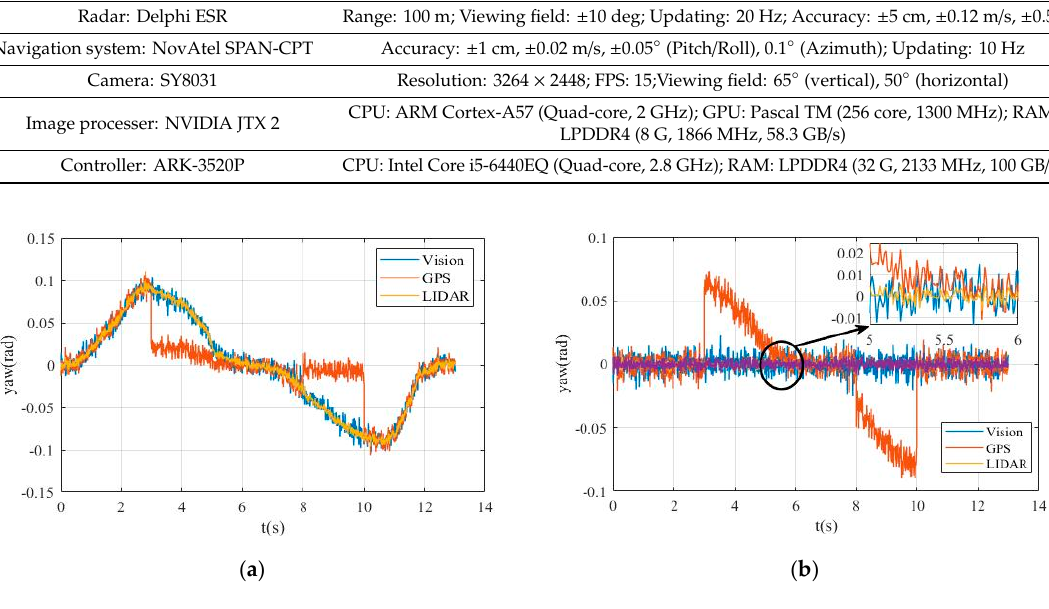
Figure 6. The yaw angle changes in simulation: ( a ) detected yaw angle using different sensors; and ( b ) the yaw angle error.